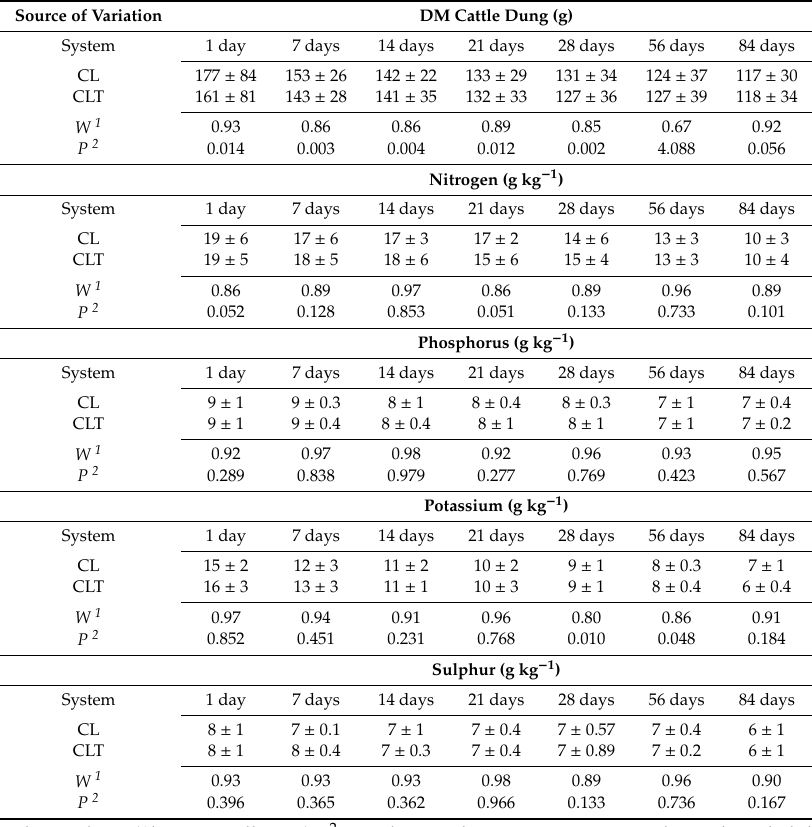
Table 5. Initial dry matter (DM) residue from the cattle dung and nutrient (N–P–K and S) concentrations (means ± standard error) for each system (CL, crop–livestock and CLT, crop–livestock–tree systems) and for time (1, 7, 14, 21, 28, 56 and 84 days after grazing commenced). Source of